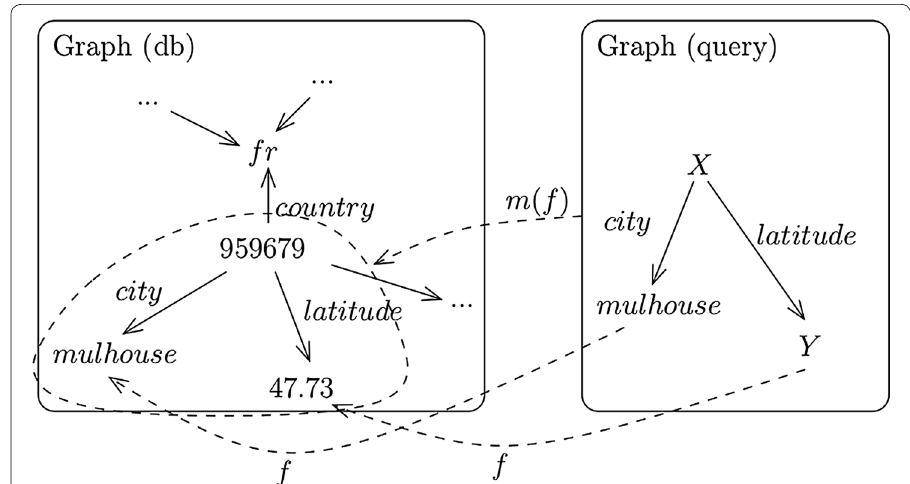
Fig. 4 Sample graphs and